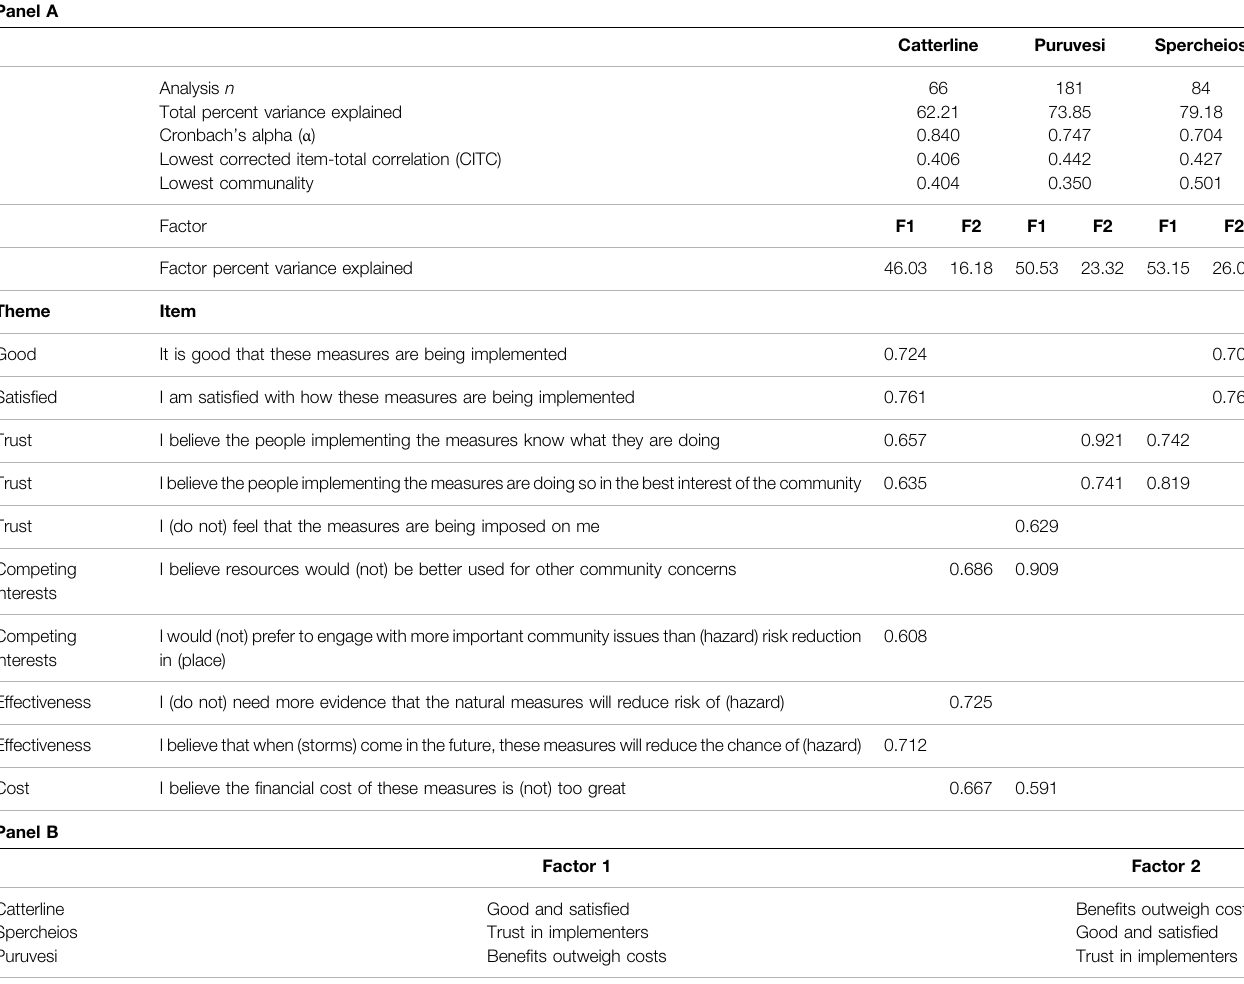
TABLE 3 | (A) Rotated structure matrix output (promax) from principal axis factoring to determine latent variables of attitudinal acceptance in each of the three study sites. Items were standardized for direction when necessary so that increasing scores equated to increasing acceptance. All items were fi rst included and iteratively removed one-by-one from the analysis to maximize reliability and percent variance explained within each site. Two dimensions of attitudinal acceptance best explain the variance in each site.Onlythehigher factorloadingbetweeneach ofthetwofactors (F1and F2)per itemisshown here,sincethese wereused toderive weightedaveragefactorscores for further analyses. For full scale reliability and EFA outputs (initial and fi nal, after iterative item removal) see supplementary material ( Supplementary Table S3